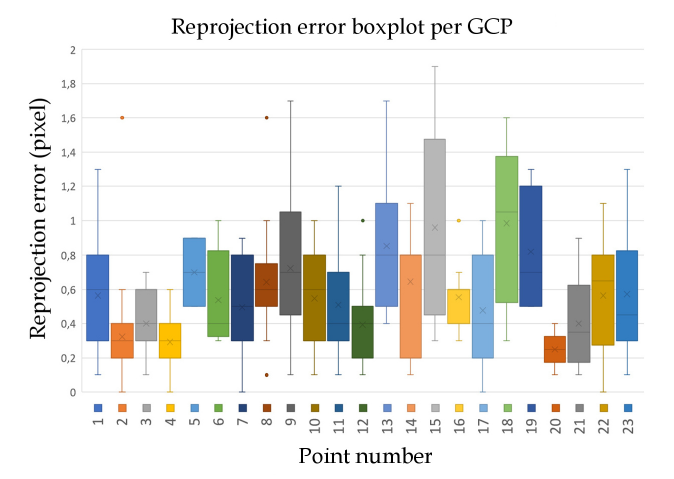
Figure 6. Reference module—Boxplots of the reprojection errors for each ground control